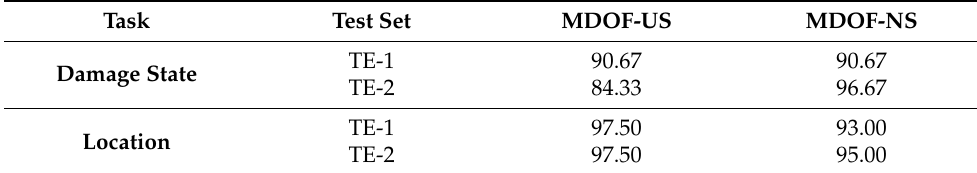
Table 4. Damage state and location accuracy (%) for the two MDOF models. Task Test